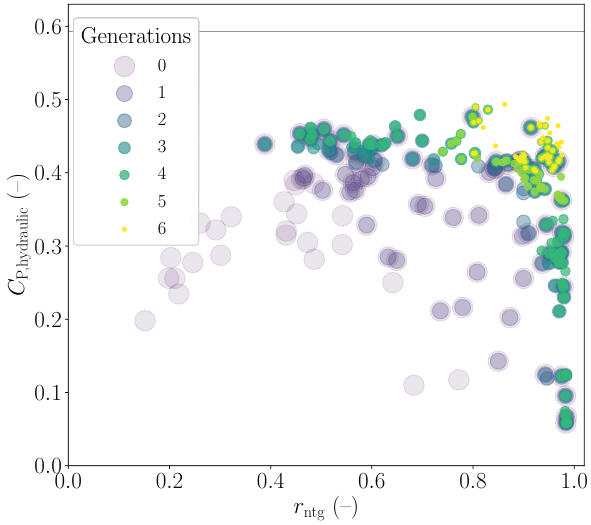
Figure 4. Performance of all cases evaluated during the optimisation, coloured according to gener- ation, with hydraulic power coefficient on the vertical axis and work ratio on the horizontal axis. A horizontal line at y = 0.593 indicates the Betz